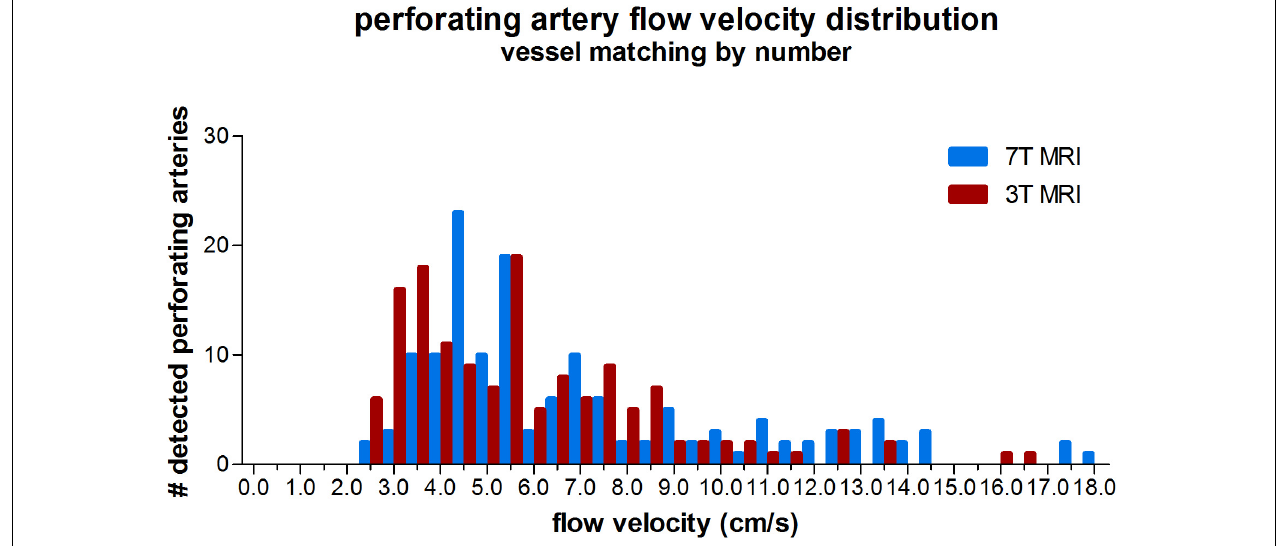
FIGURE 4 | Histogram showing the velocity distribution of all detected vessels of 3 tesla (T) MRI vs. 7T MRI, where for 7T for each individual only the N vessels with highest velocities were taken ( N refers to the number of vessels detected on 3T MRI for a given subject), in order to equalize the sensitivity to detect cerebral perforating arteries for both modalities.